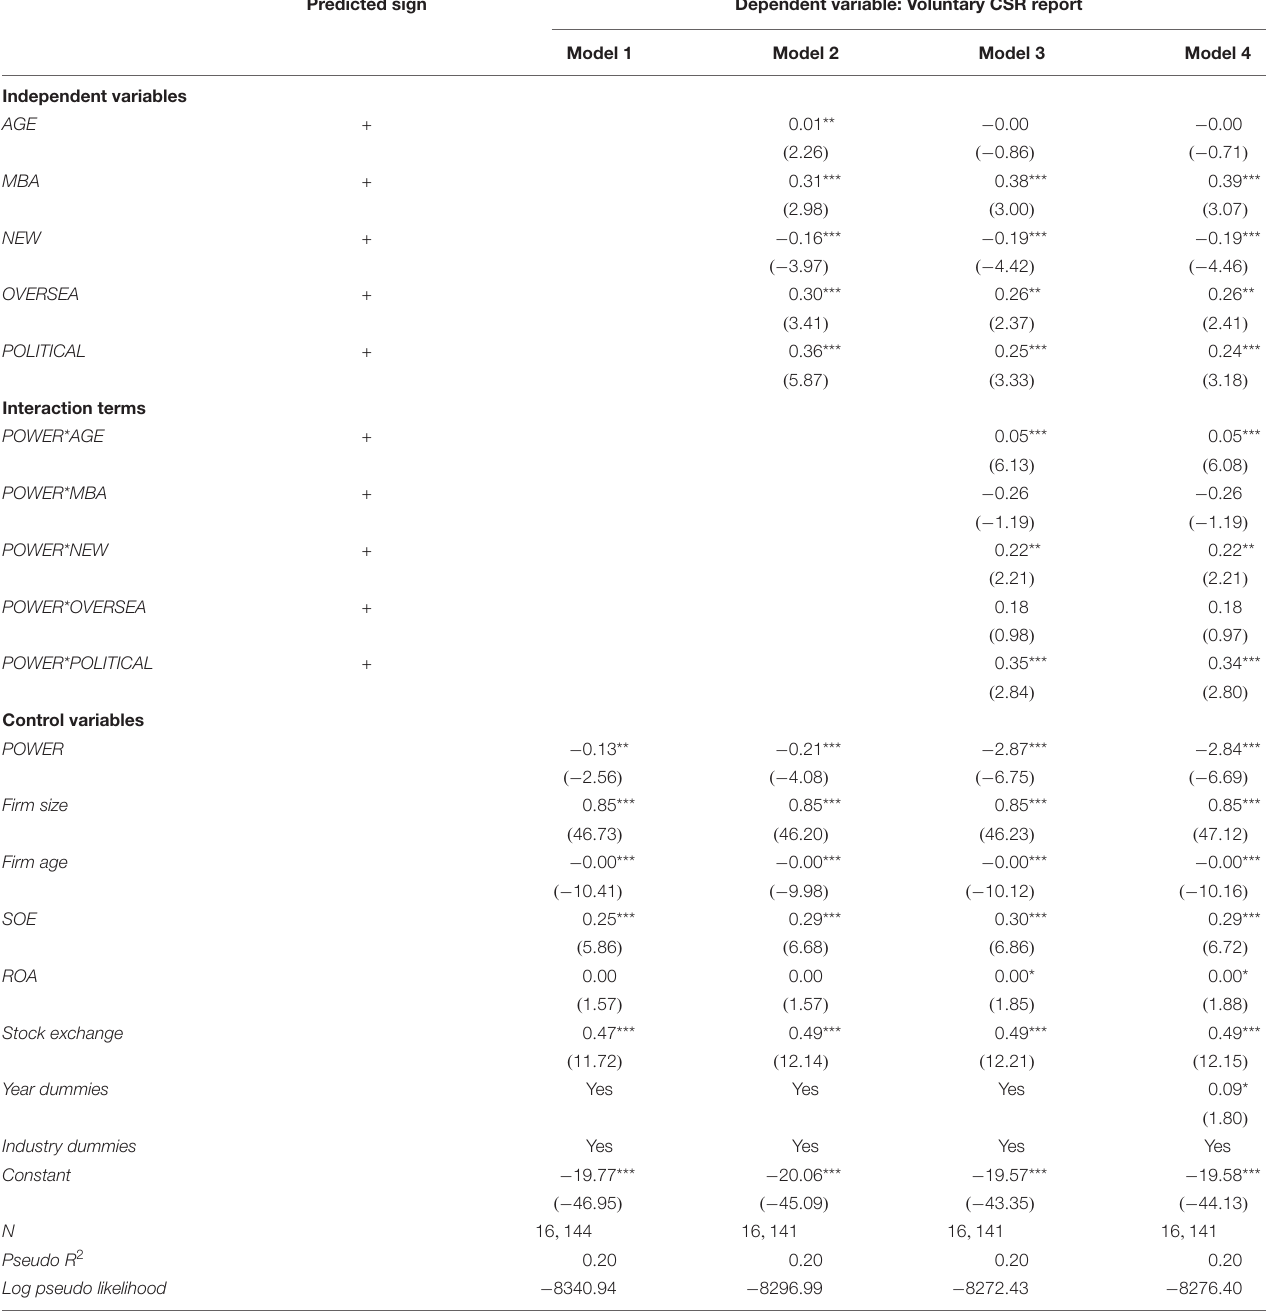
TABLE 3 | Logit regression models predicting the likelihood of volunteer corporate social responsibility (CSR) reporting for Chinese-listed